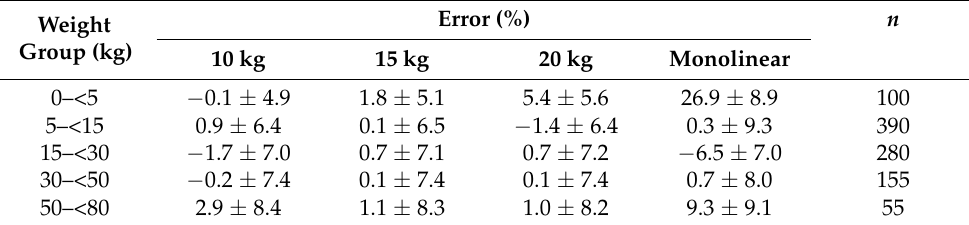
Table 4. Weight cutoffs for bilinear fitting and error of CTDIvol estimation.